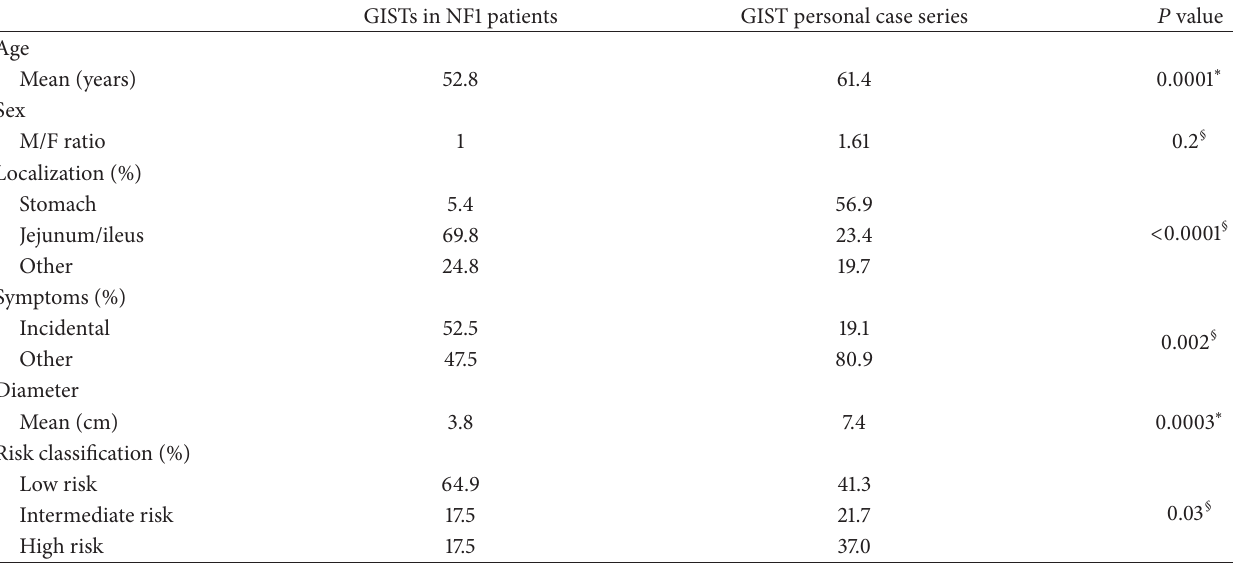
Table 3: Comparison between GISTs presenting in NF1 patients and sporadic